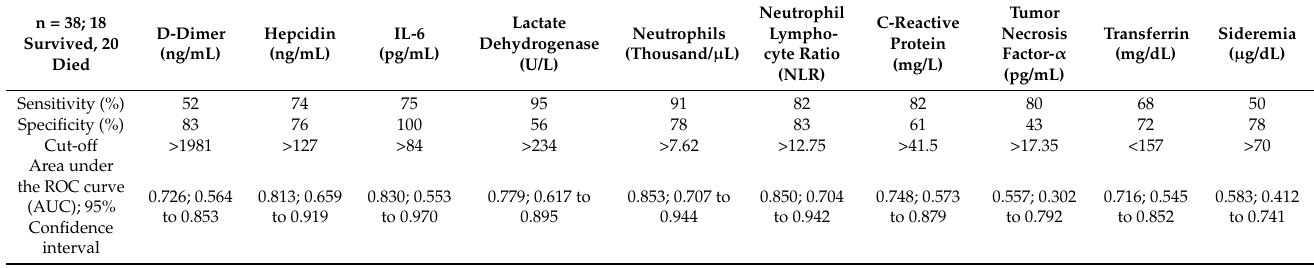
Table 2. ROC curve analysis of laboratory parameters in non-survivors and survivors’